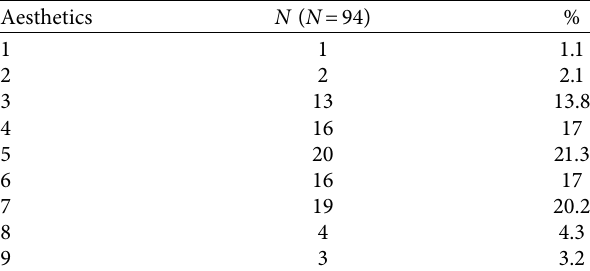
Table 6: Scores of the aesthetic: ICON.